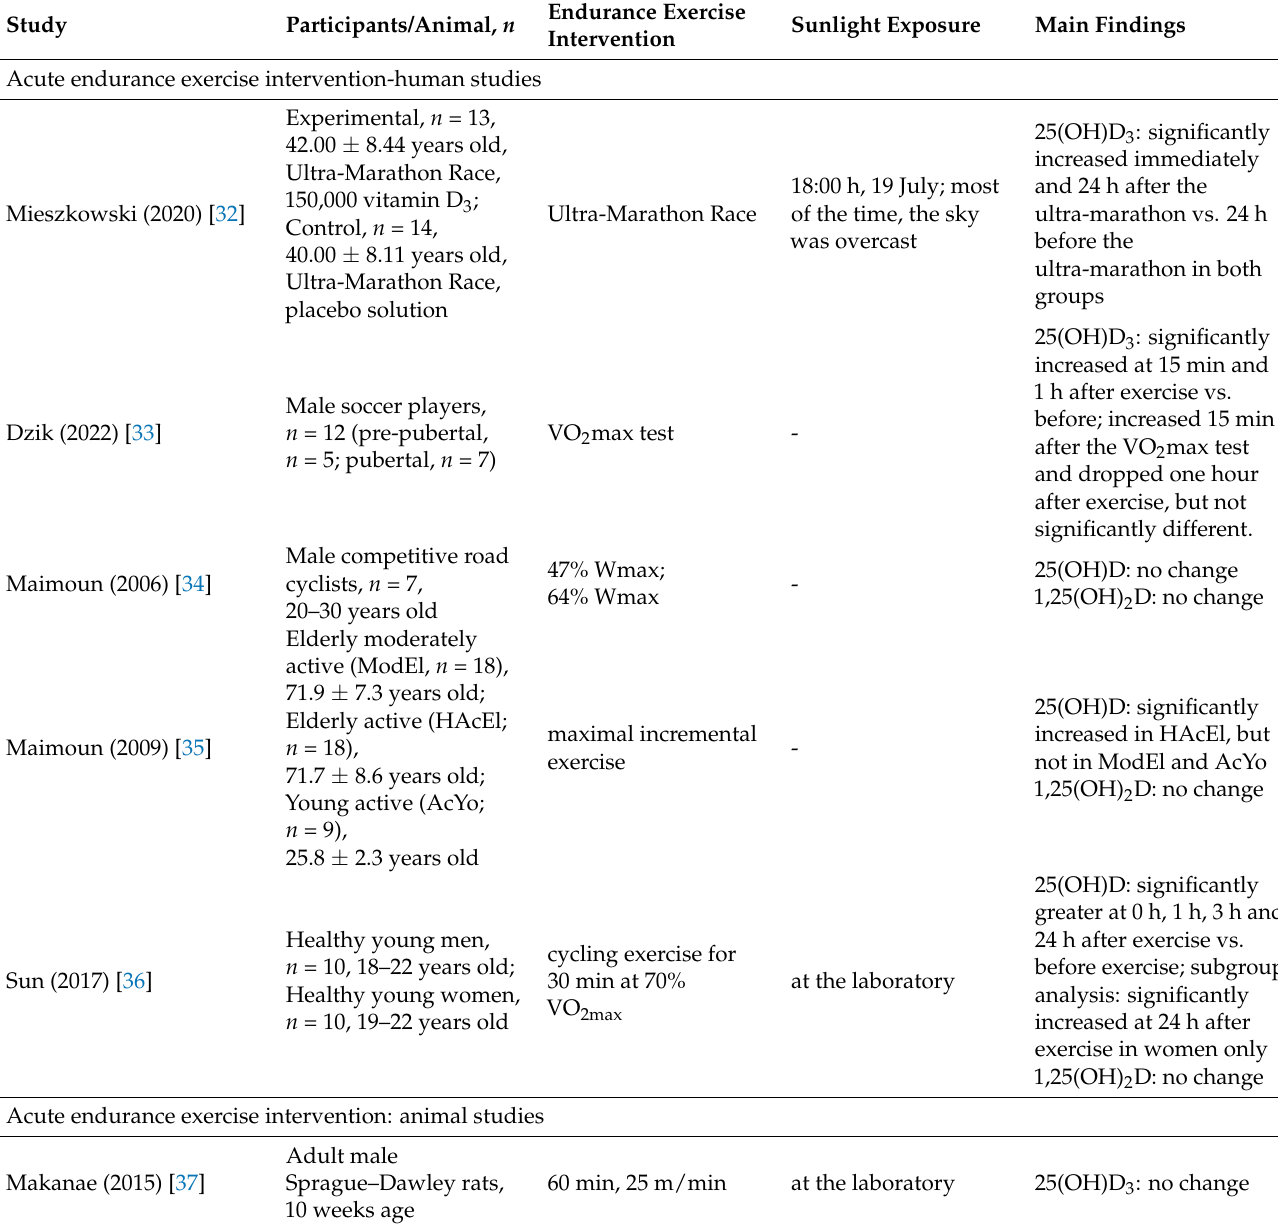
Table 1. Summary of the effect of acute endurance exercise